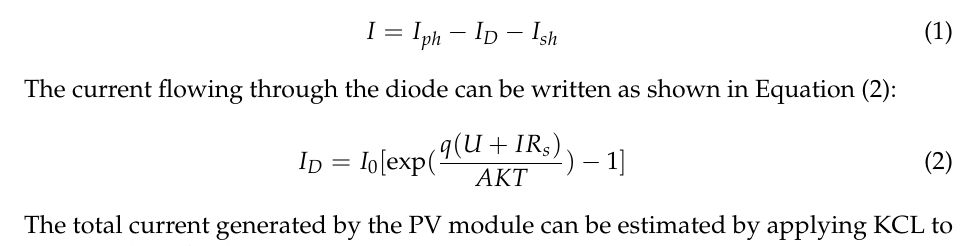
Figure 2. Equivalent circuit of a photovoltaic cell.